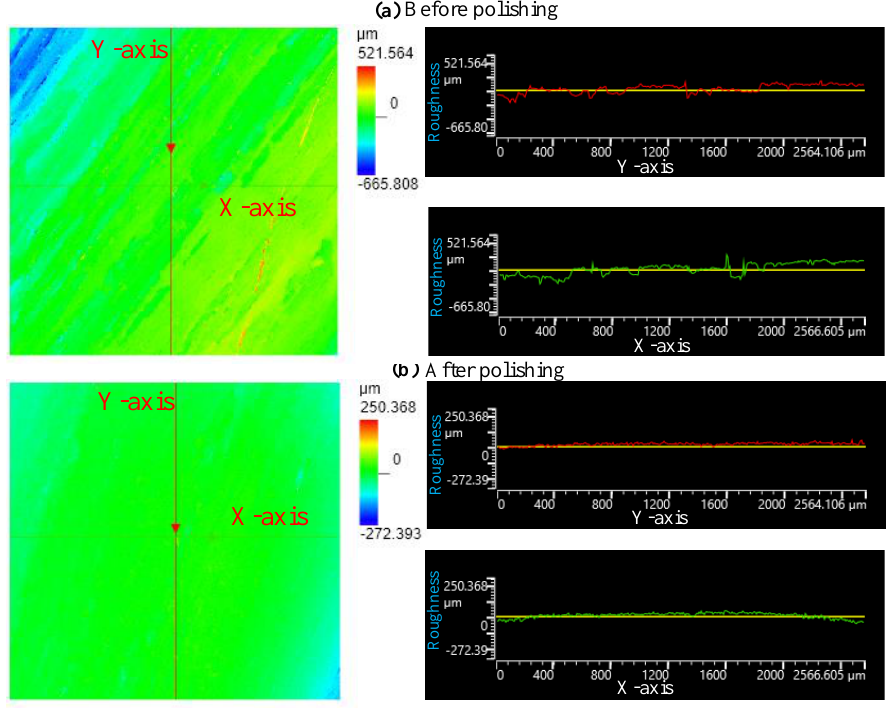
Figure 12. Surface microstructure on P01 of path1 in 2D ( a ) before polishing, ( b ) after polishing.